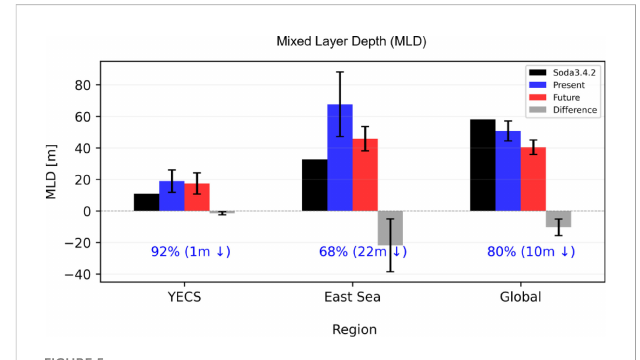
FIGURE 5 Future changes in Mixed Layer Depth (MLD) by regions (YECS, East Sea (35.5°N-44.5°N, 130°E-140°E), Global Ocean) of Multi-Model Ensemble Mean (MMM) of 13 CMIP6 models. Black bars represent the climatological MLD for 35 years from 1980 to 2015 using SODA 3.4.2 re-analysis data. Blue and red bars indicate MLD of the present and future period respectively. Gray bars represent the difference between the present and future periods. Crosses are spread over 13 models